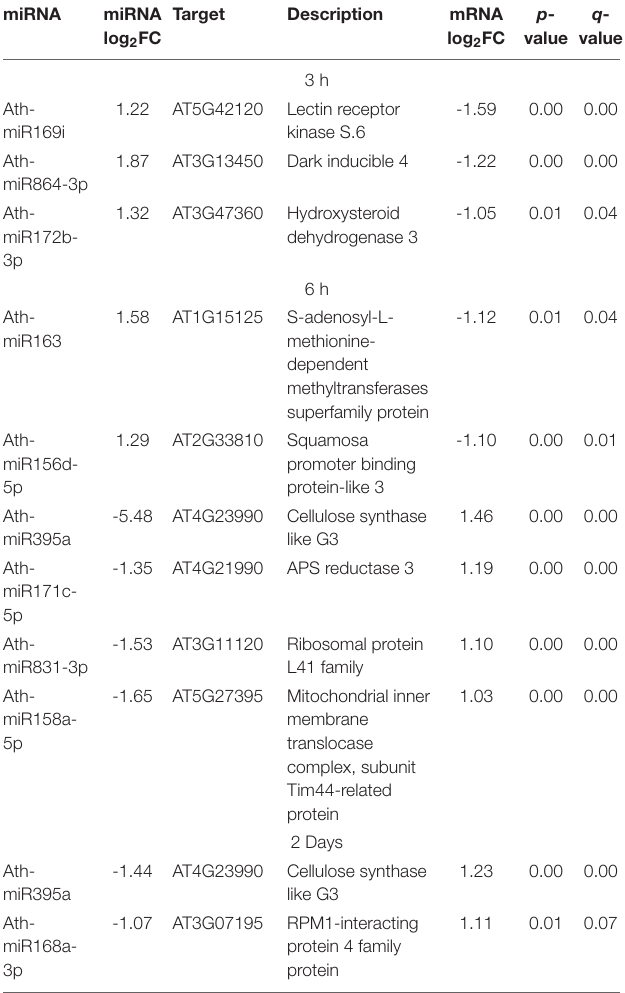
TABLE 2 | List of miRNA:mRNA target pairs showing inversely correlated expression in response to high light treatment after 3 h, 6 h, and 2 days